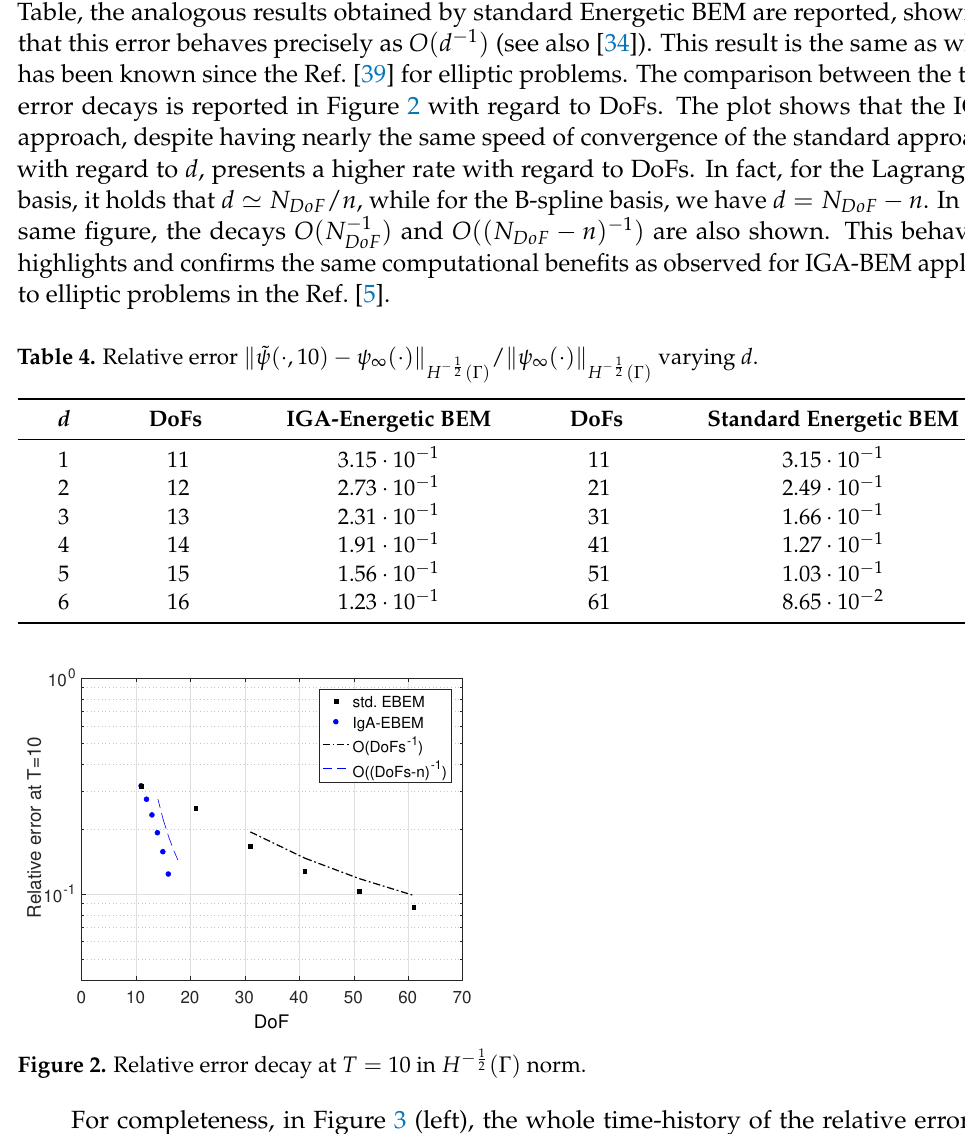
Figure 2. Relative error decay at T = 10 in H − 1 2 ( Γ )